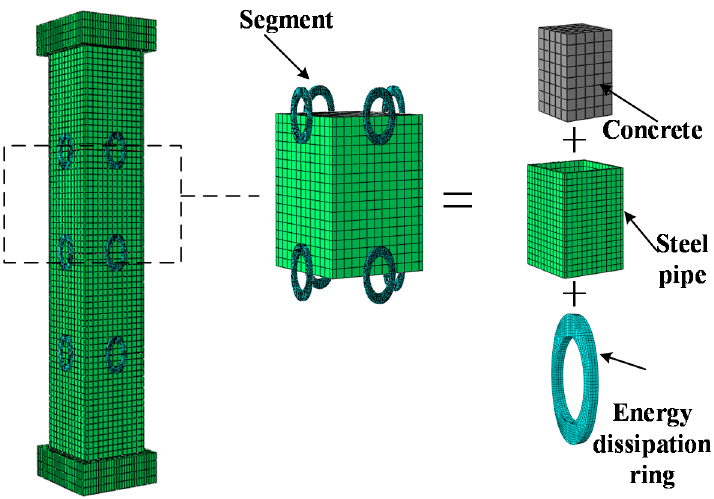
Figure 9. Finite element model of precast assembled pier.